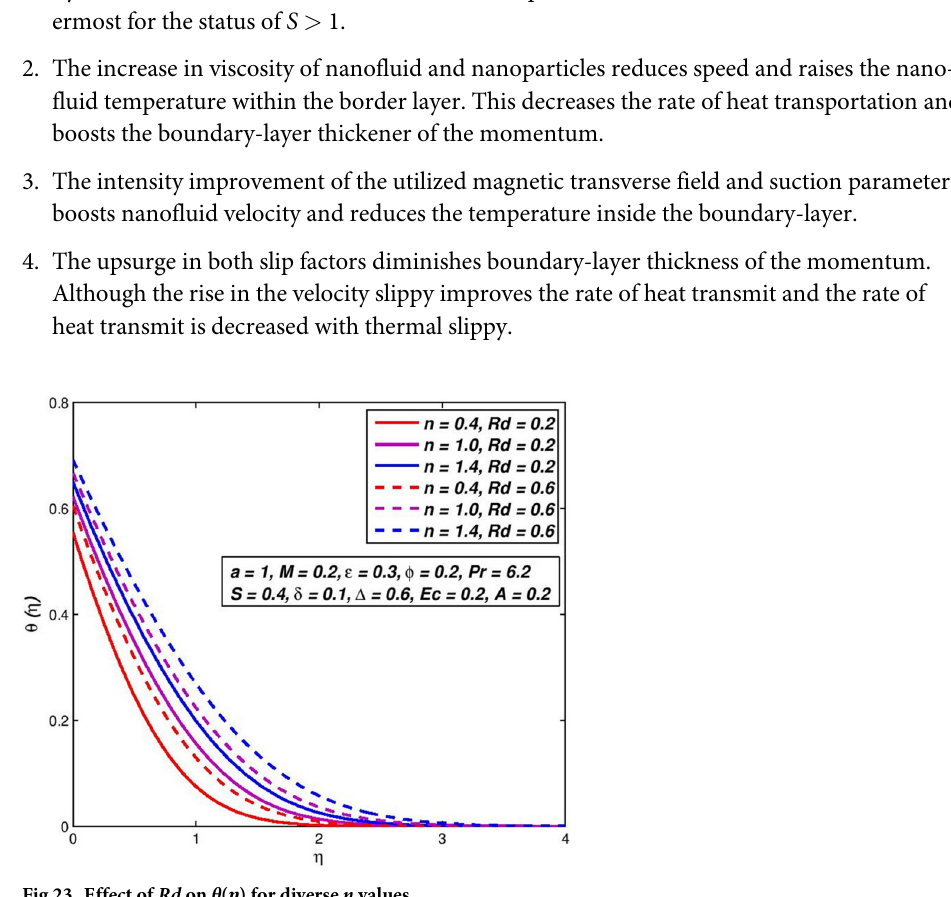
Fig 23. Effect of Rd on θ ( η ) for diverse n